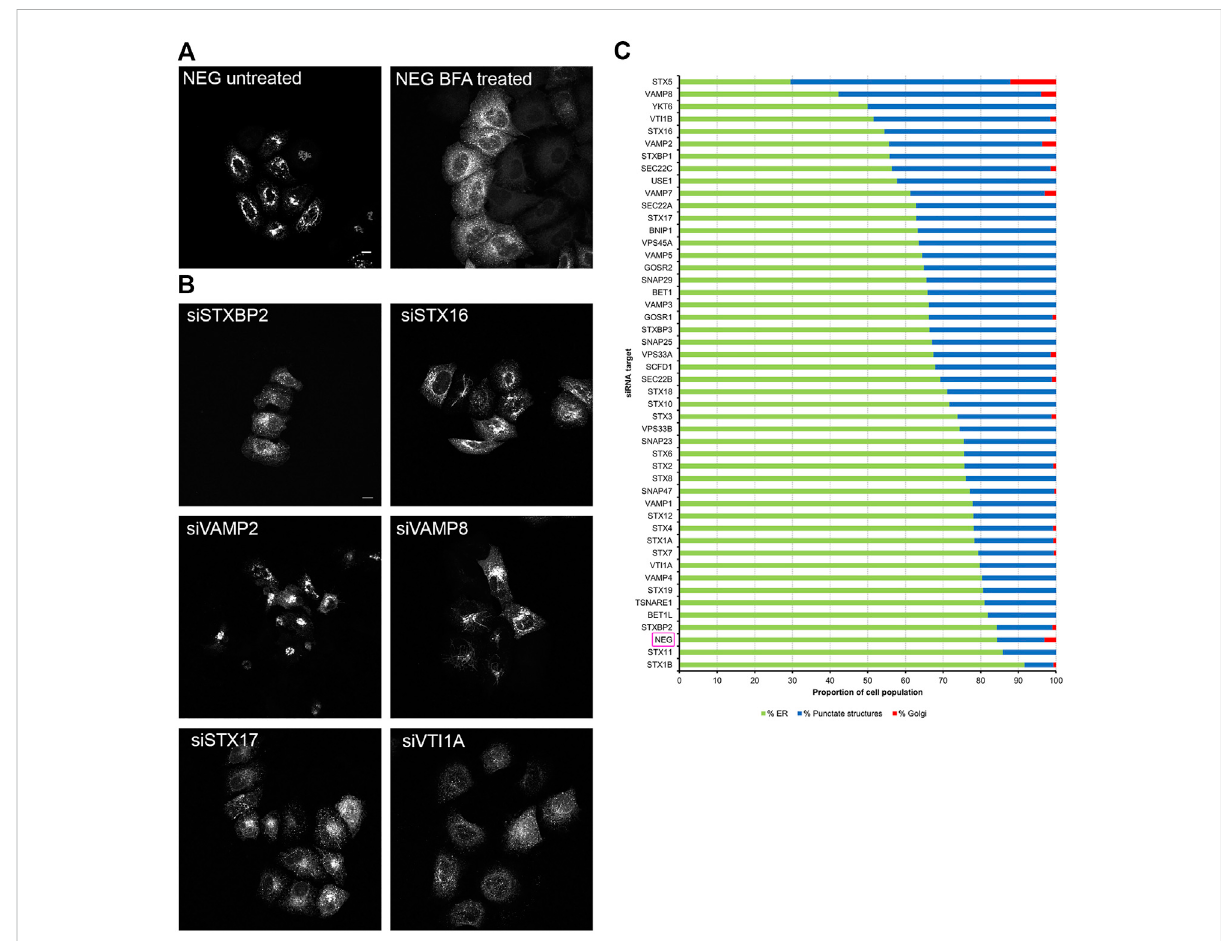
FIGURE 3 Golgi redistribution assay in EGFP-KDELR transfected cells. Cells were transfected with siRNAs for 48 h, followed by transfection with EGFP- KDELR constructs for 12 h. Cells were treated with 10 μ g/ml BFA for 15 min at 37 ° C and then fi xed and stained with 0.2 μ g/ml Hoechst 33342. (A) Representative confocal images of siNEG-treated EGFP-KDELR expressing HeLa Kyoto cells, either untreated or treated with BFA. Scale bar: 10 µm. (B) RepresentativeimagesofBFAtreatedEGFP-KDELRexpressingHeLaKyotocellsincubatedwithvarioussiRNAsagainstSNAREorSNARE-like proteins. Images represent different phenotypes observed. Scale bar: 10 µm. (C) Quantitative analysis of the EGFP-KDELR redistribution assay. A minimum of 100 cells transfected with EGFP-KDELR constructs were analysed per siRNA treatment (y-axis) and categorised into three phenotypic groups,namelyER(greenbars) — cellsdisplayingahigh fl uorescentsignalinperipheralareas;punctatestructures(bluebars) — cellswithadistribution of fl uorescent signals in juxta-nuclear punctate structures; and Golgi (red bars) — cells with an intense juxta-nuclear signal. The percentage of cells per treatment within each group is displayed on the x-axis. Data are represented as the mean of two independent